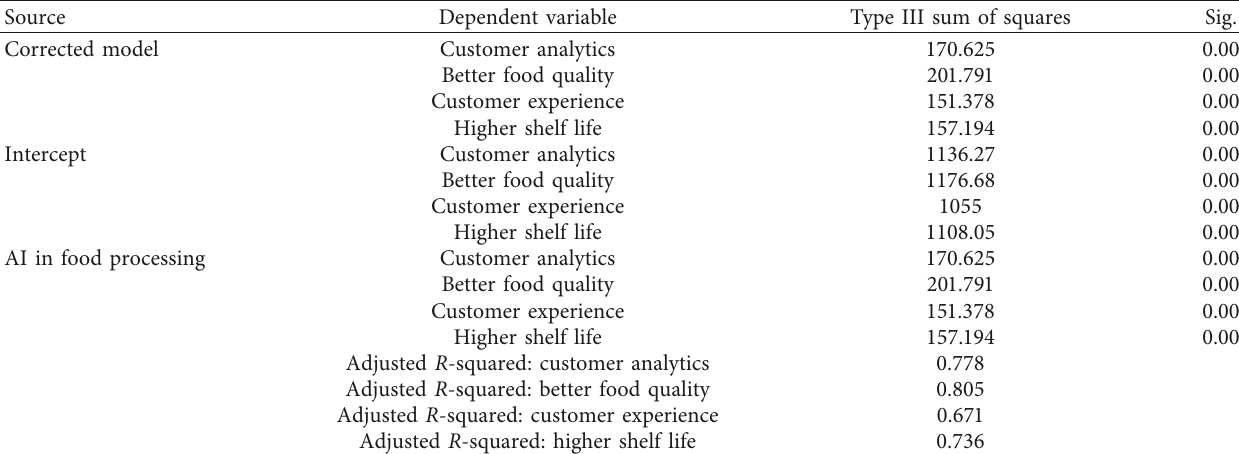
Table 5: Tests between subjects’